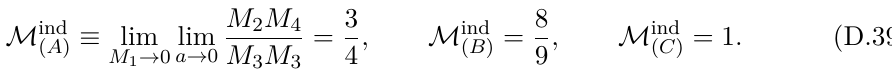
Figure 6 : Plots of the direct method ratios M dir ily (4.30) with h = 1 as a function of x . The blue dashed lines indicate the indirect method values given in